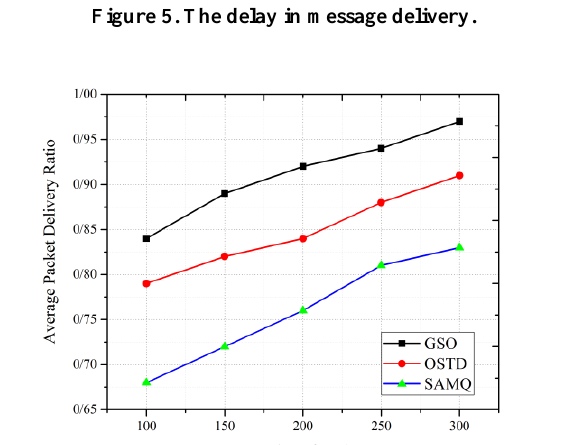
Figure 5. The delay in message delivery.